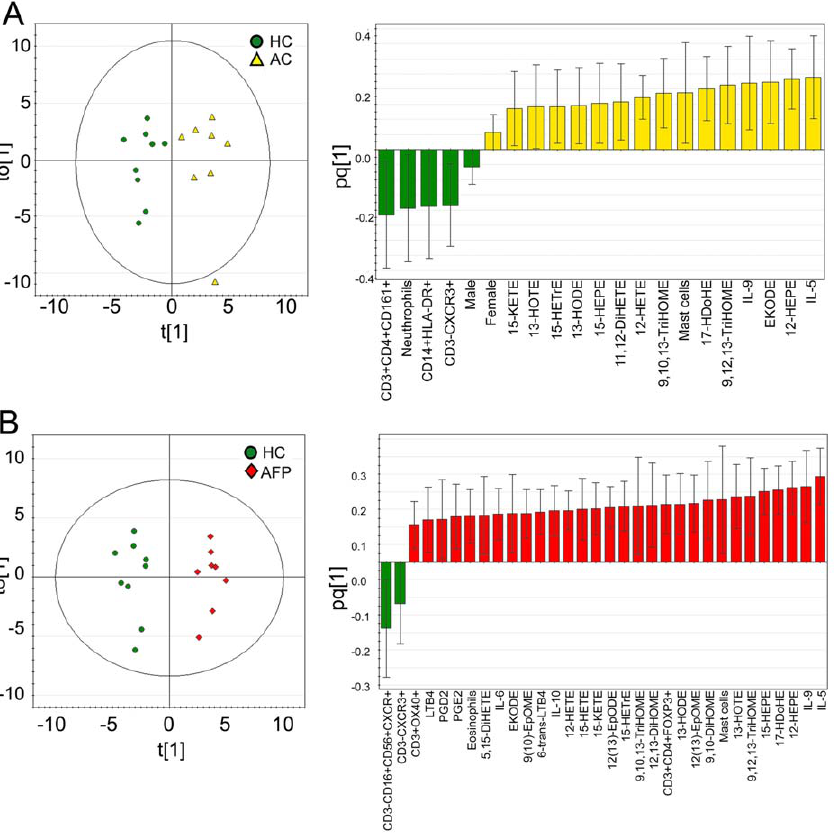
Figure 3. OPLS score and loading column plots with respect to separation according to diagnosis. Loading column plots visualize variables correlating with healthy ( 2 ) or asthmatics ( + ), error bars indicate 95% confidence interval. The number of variables correlating with the asthmatic population with 95% confidence increases following provocation from n=21 to n=32. ( A ) Healthy controls (green) and asthmatic controls (yellow) (R 2 Y[cum]=0.87, Q 2 [cum]=0.51). ( B ) Healthy controls (green) and asthmatics following provocation (red) (R 2 Y[cum]=0.95, Q 2 [cum]=0.73).